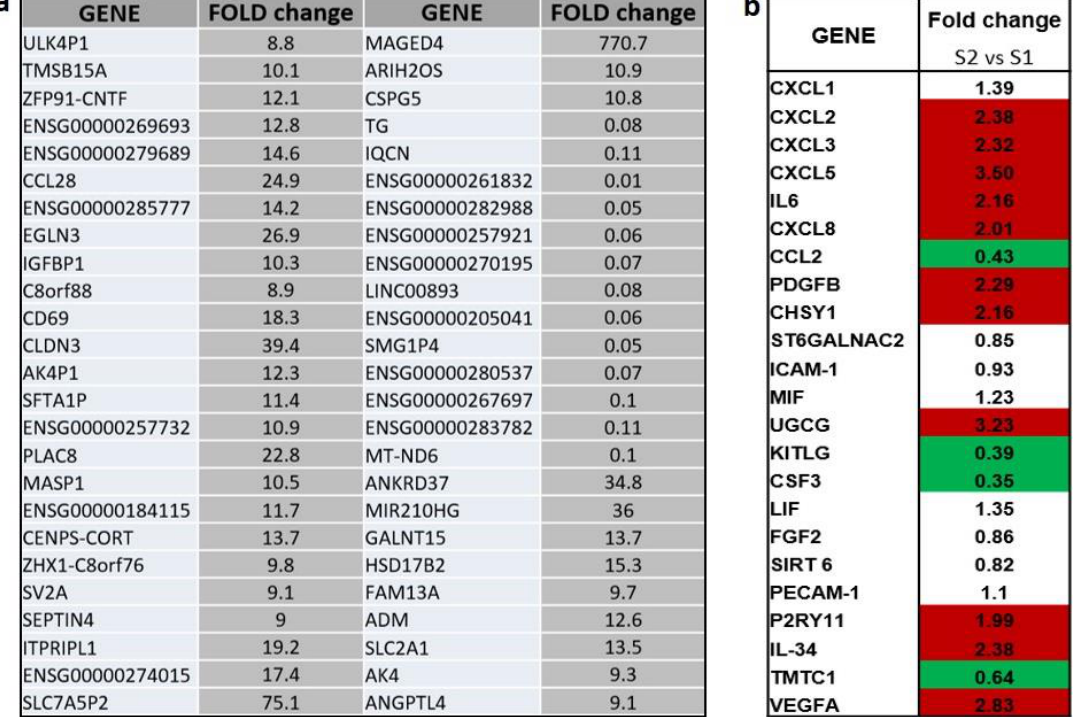
Figure 4. ( a ) Using 2 log FC and DEG table provided from BMR Genomics, fold-changes in gene expression of the 50 most variable genes were calculated. ( b ) Increased fold-changes of some upregulated genes ( red color ) in HUVECs maintained for 8 h in anoxic condition ( S2 ) with respect to cells in normoxia ( S1 ) and decreased fold-changes of some downregulated genes ( green color ) which are said to be involved in the hematopoietic niche environment.